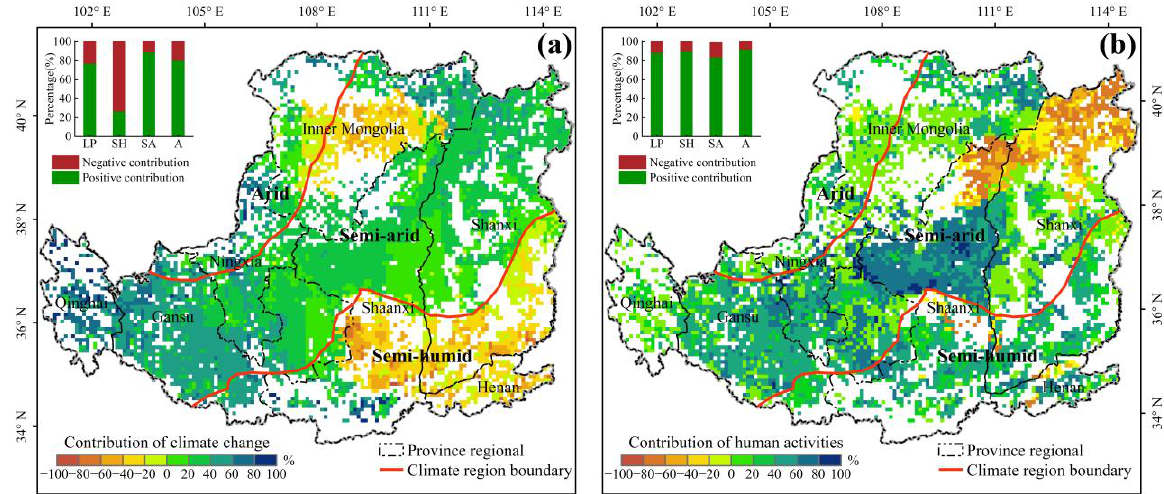
Figure 8. Spatial distributions of contributions of climate change ( a ) and human activities ( b ) to change in the drought resistance of vegetation on the LP. Top-left insets show contributions across climate zones.